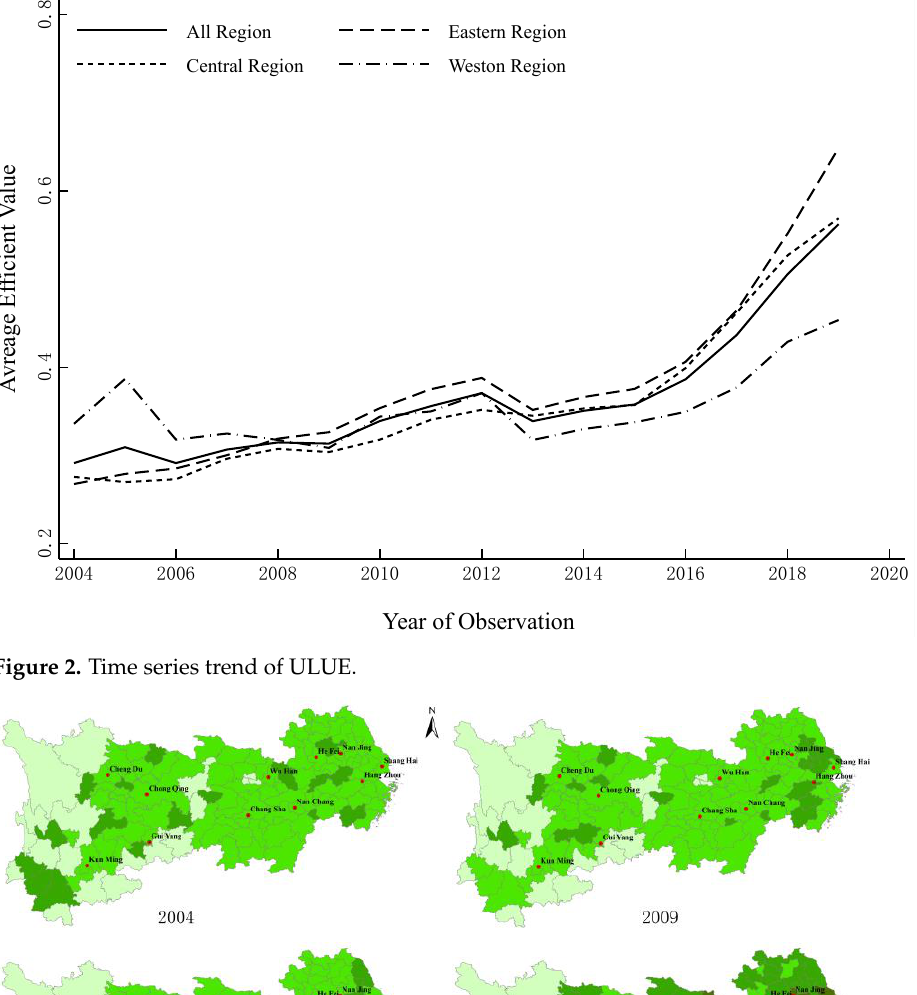
Figure 2. Time series trend of ULUE.